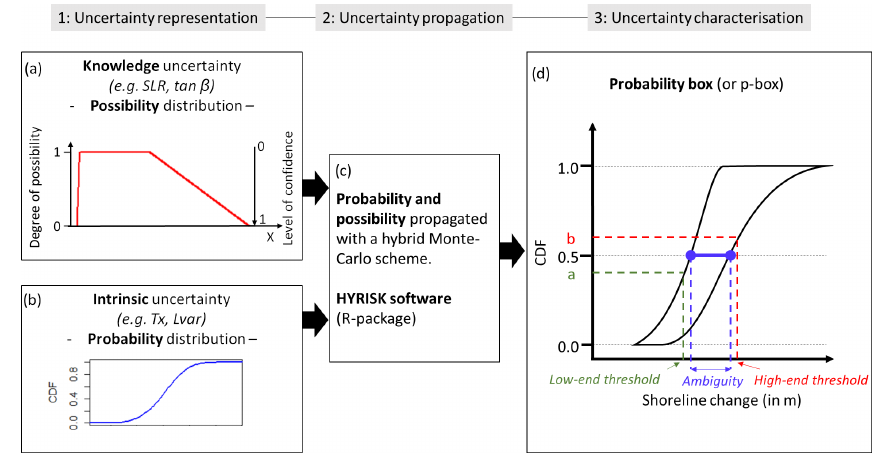
Figure 2. Schematisation of the framework used herein to perform future shoreline change projections within the extra-probabilistic theory.